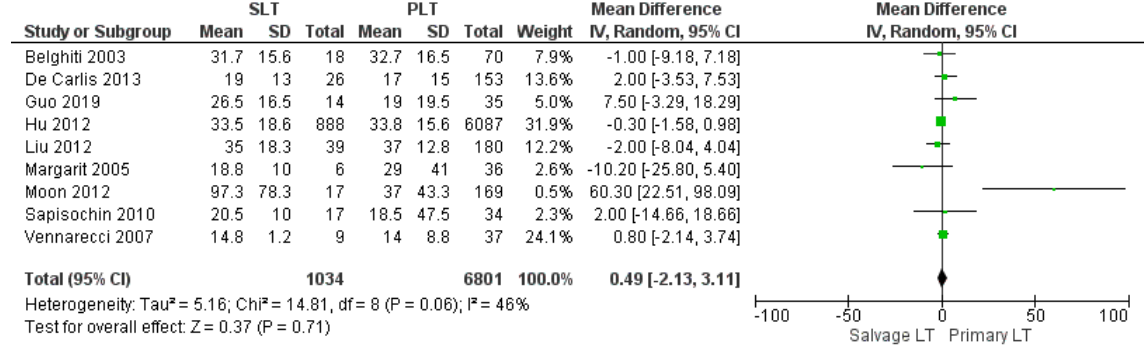
Figure 11. Length of hospital stay.